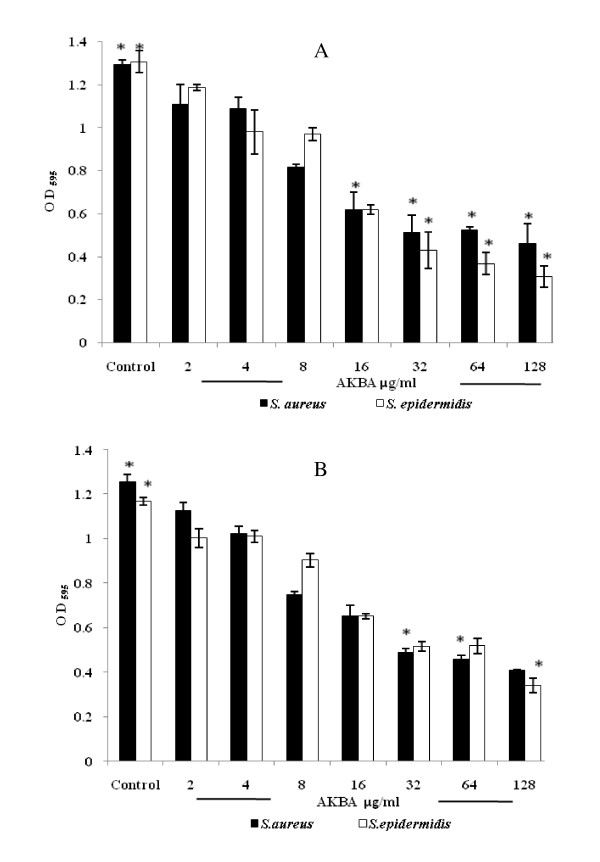
Effect of AKBA on the biofilm formation (A) and preformed biofilm (B) by S. aureus ATCC 29213 and S. epidermidis ATCC 12228. After incubation, the biofilms were stained with crystal violet and the optical density of stained adherent bacteria was determined with a multidetection microplate reader at a wavelength of 595 nm (OD595). The results are expressed as average optical density readings for crystal violet assays compared to growth control. The biofilm of S. aureus and S. epidermidis were significantly inhibited (A) and reduced (B) compared with those of bacteria without AKBA (P < 0.01). Values are mean (±SD) from four independent determinations. *, P < 0.01 (Student's t test).